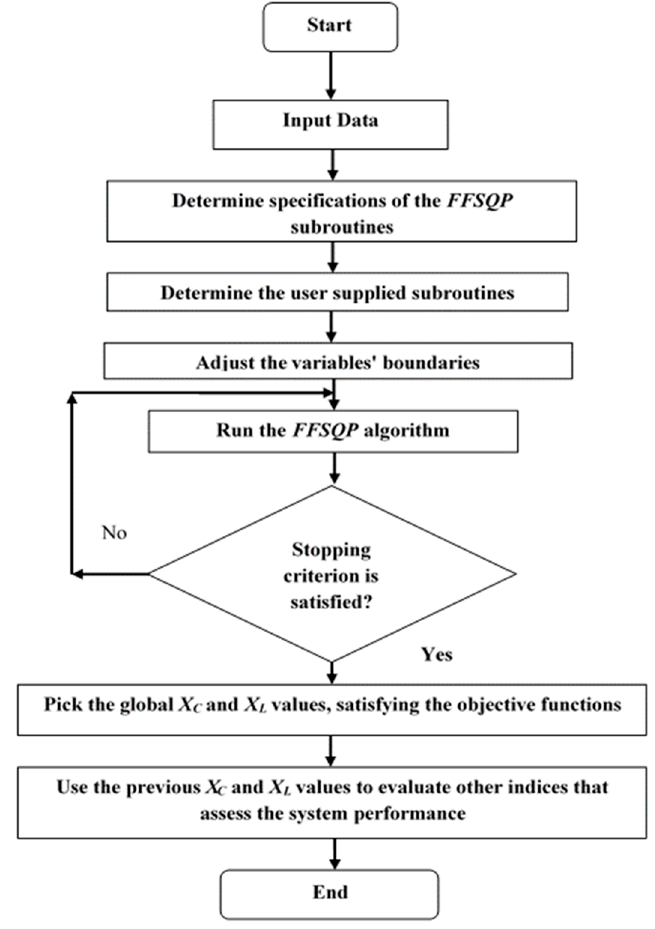
Figure 4. Flowchart of the FFSQP search algorithm.